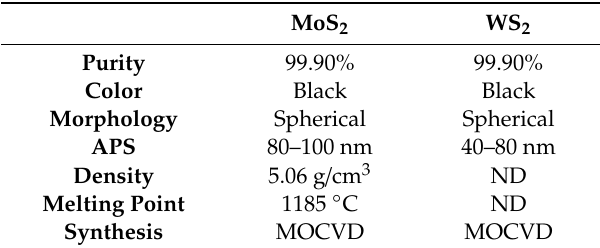
Table 1. Properties of MoS 2 and WS 2